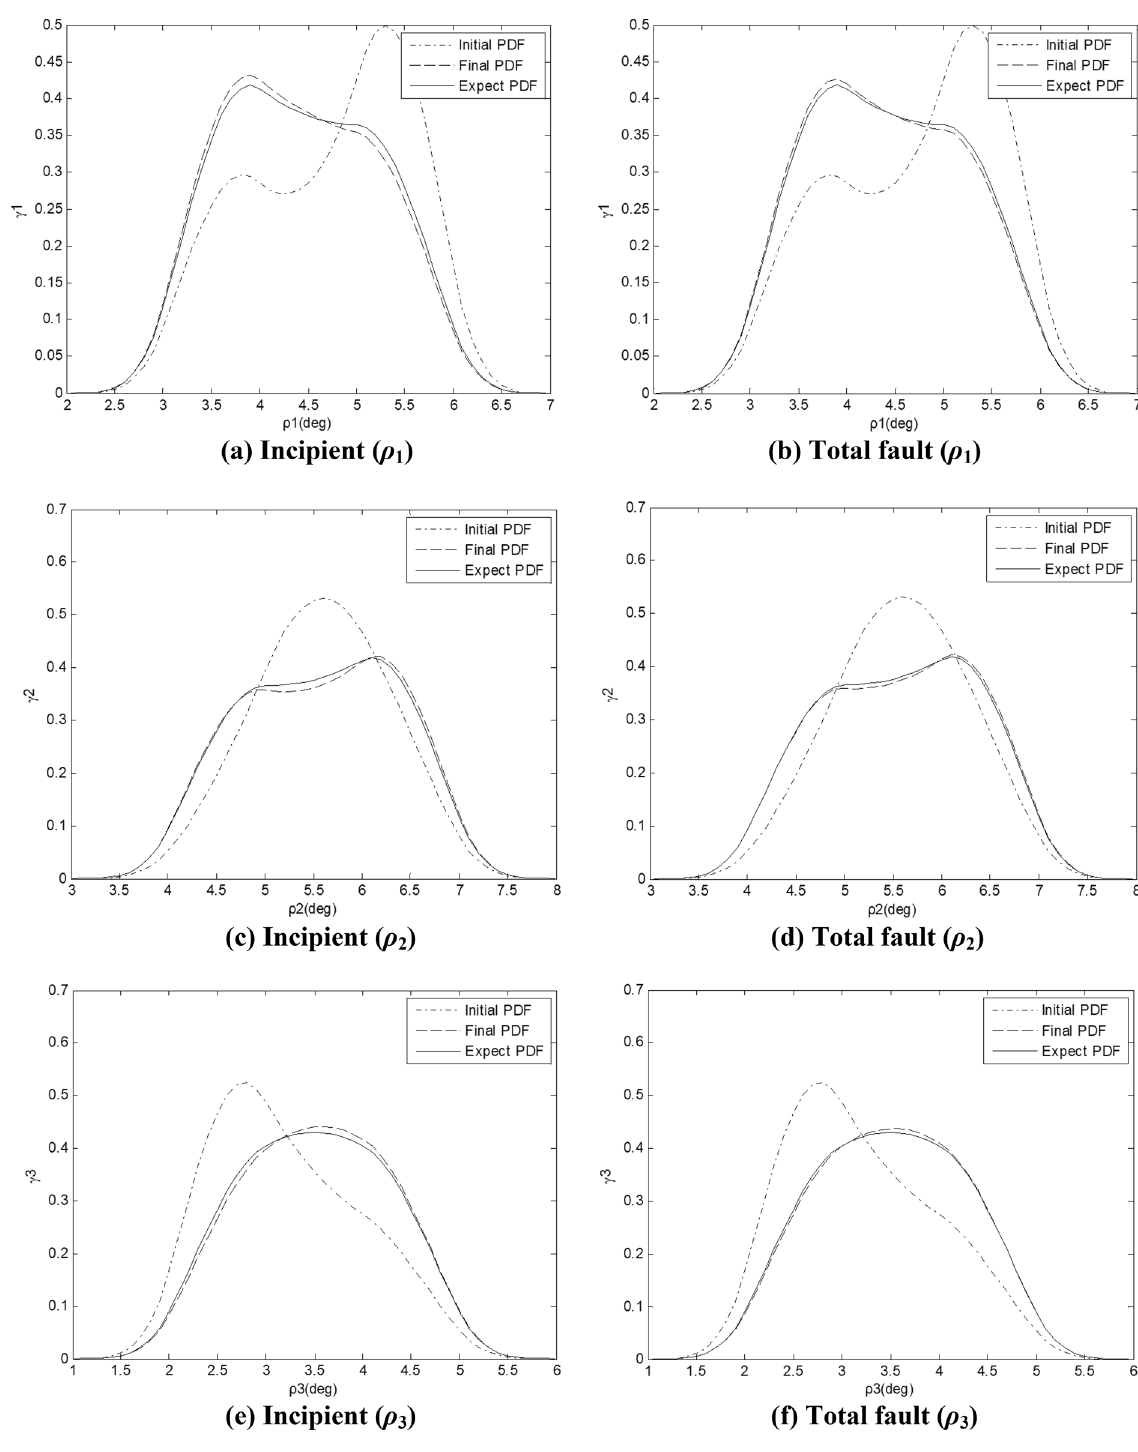
Figure 8. Expected and final PDFs.